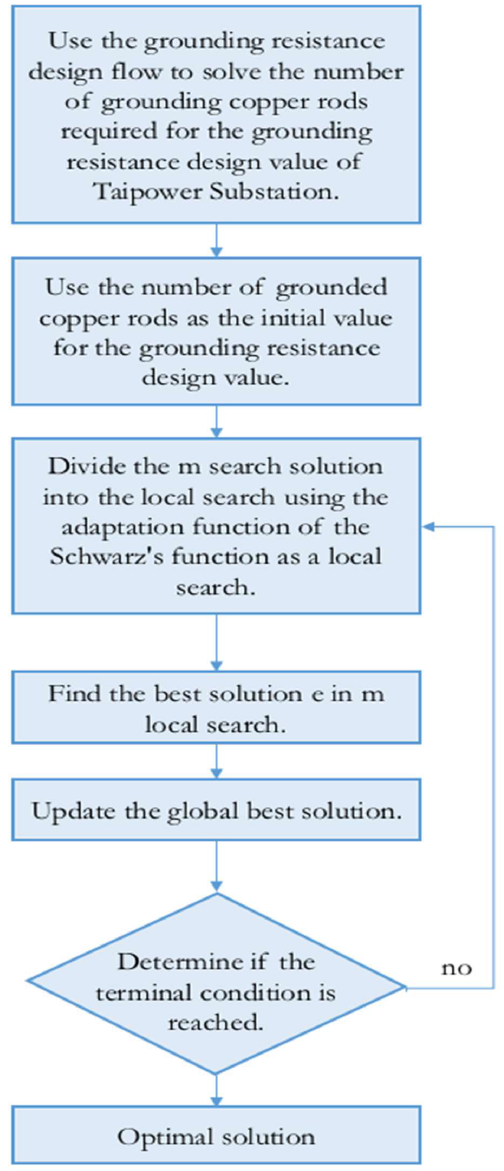
Figure 5. Flow of the grounding system with artificial bee colony algorithm optimization.